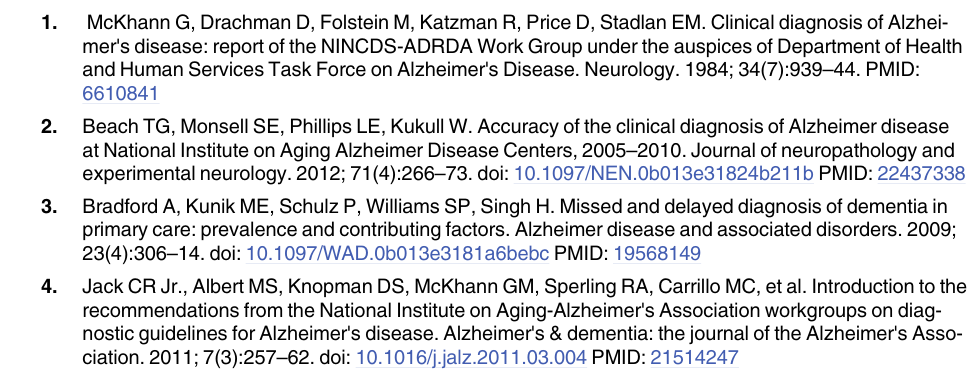
S1 Table. Age- and gender-specific normative value of normalized ROI volumes in CN sub- jects. S2 Table. Linear mixed model analyses of neuropsychological measures over 2 years in AD subjects. S3 Table. Neuropsychological measures at 1-year and 2-year follow-up in CN and AD sub-